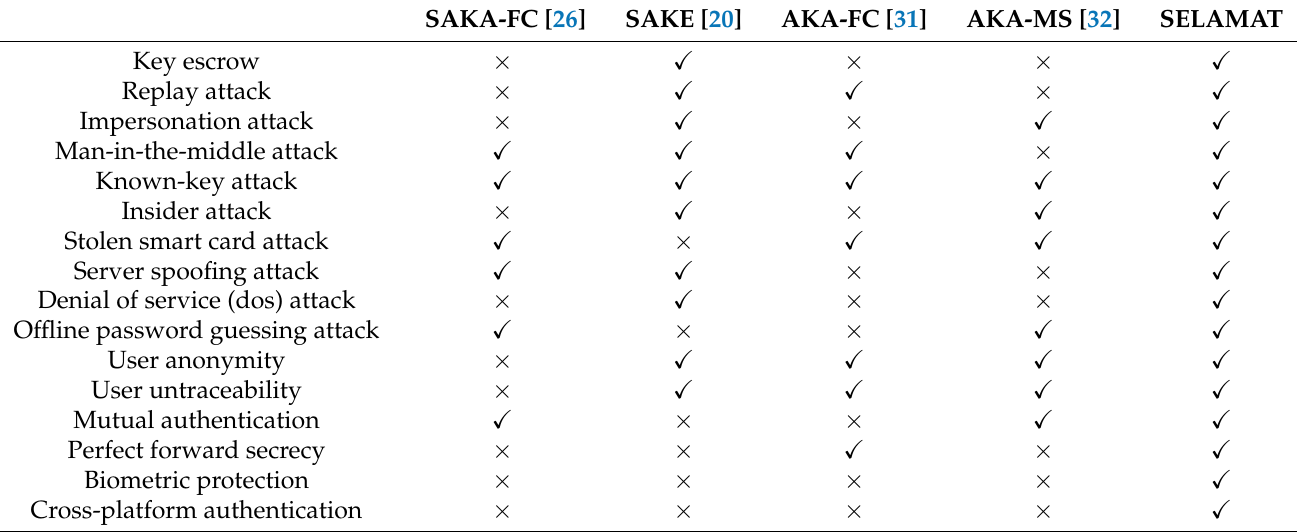
Table 4. Comparison on security